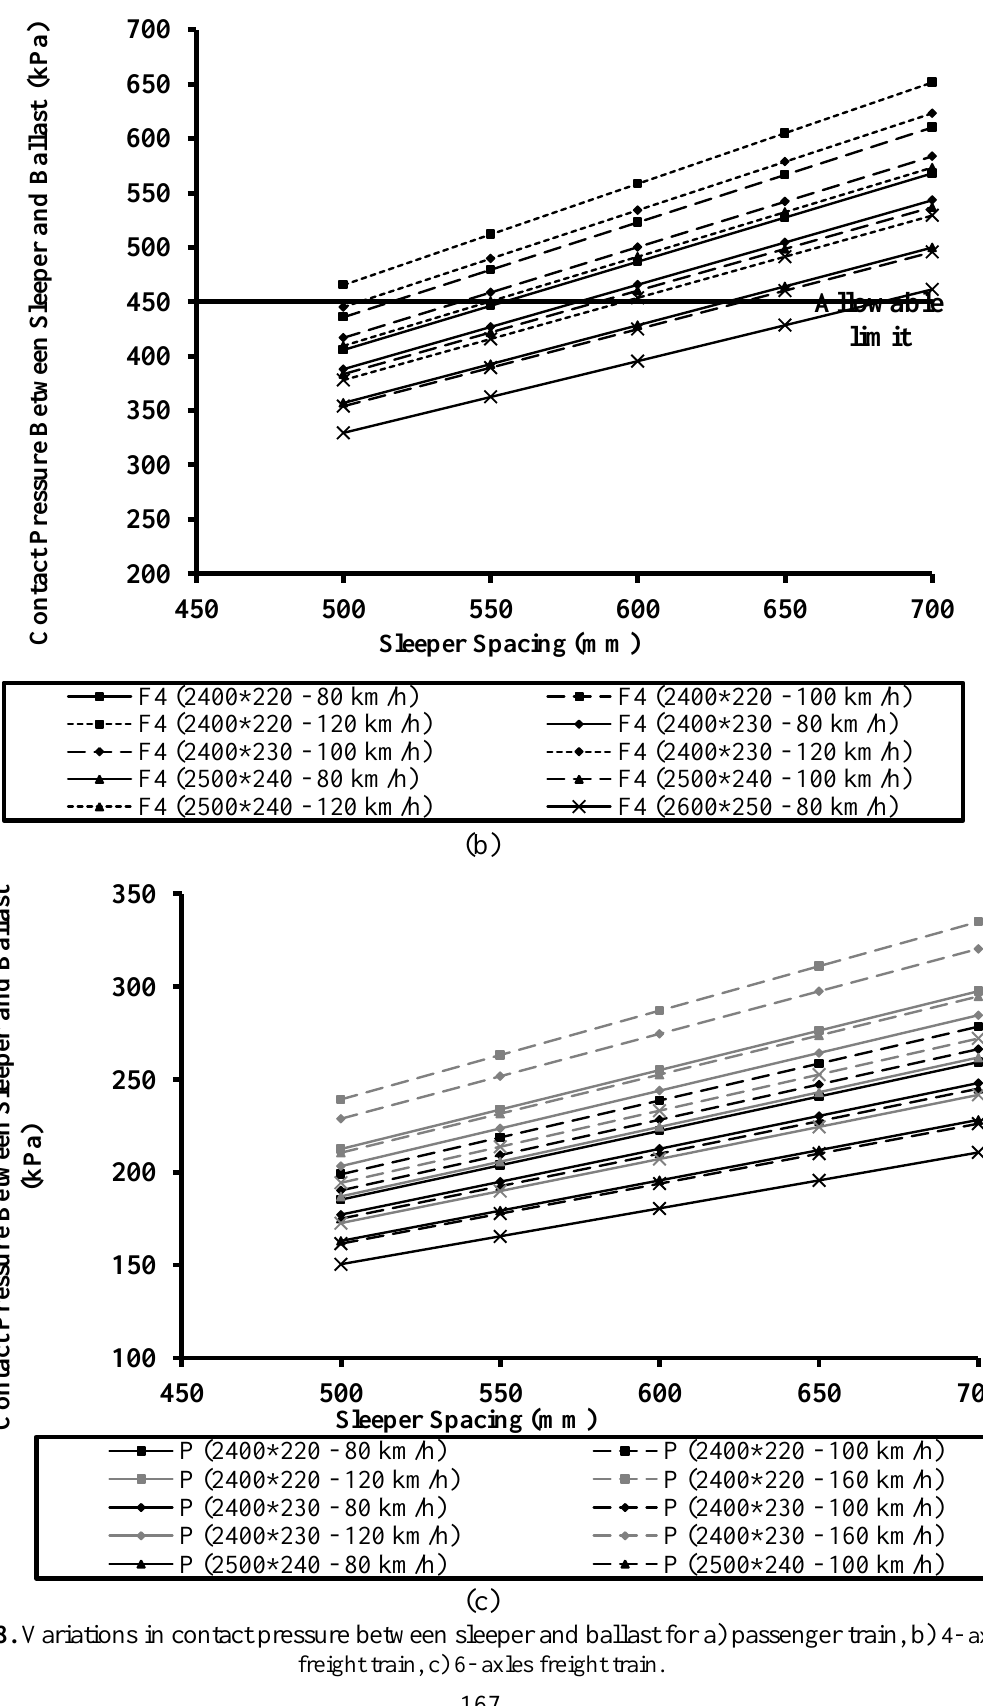
Fig. 8. Variations in contact pressure between sleeper and ballast for a) passenger train, b) 4- axles freight train, c) 6- axles freight